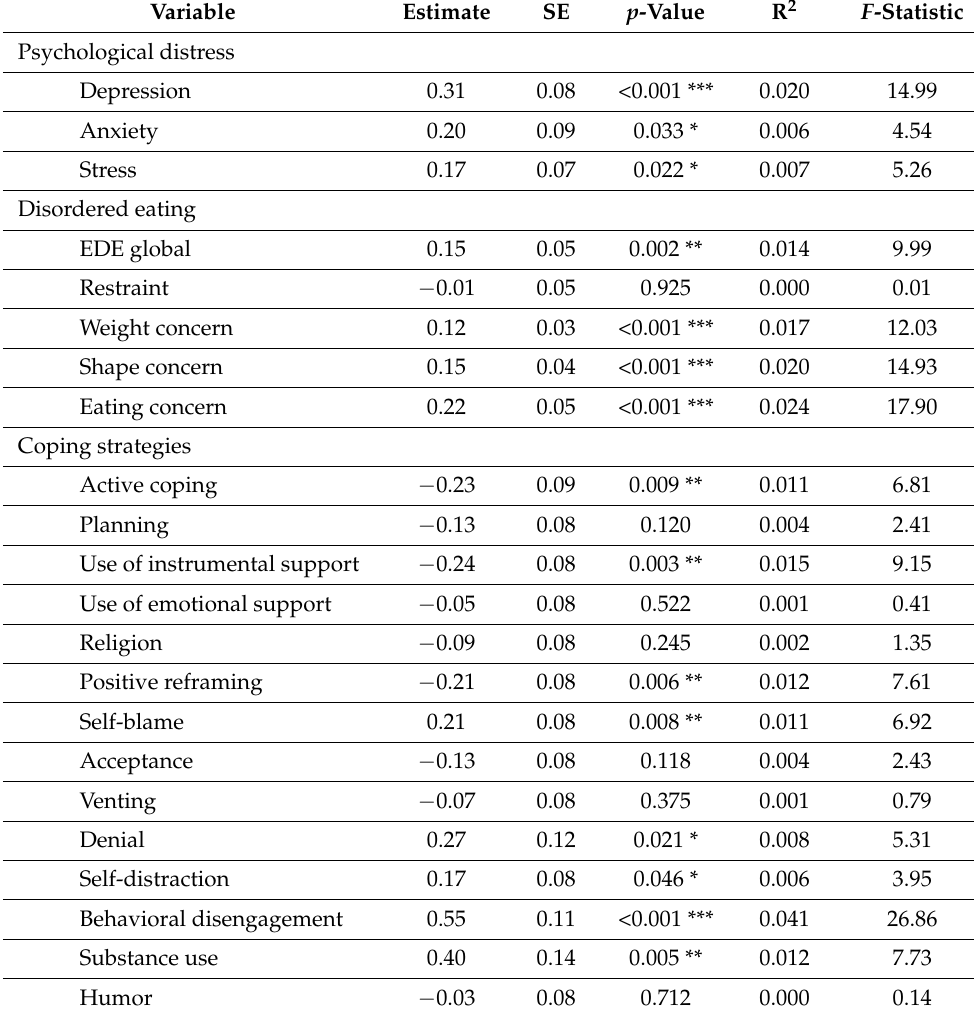
Table 2. Regression coefficients of the relationships between the predictors (psychological distress, disordered eating and coping strategies) and the outcome weight